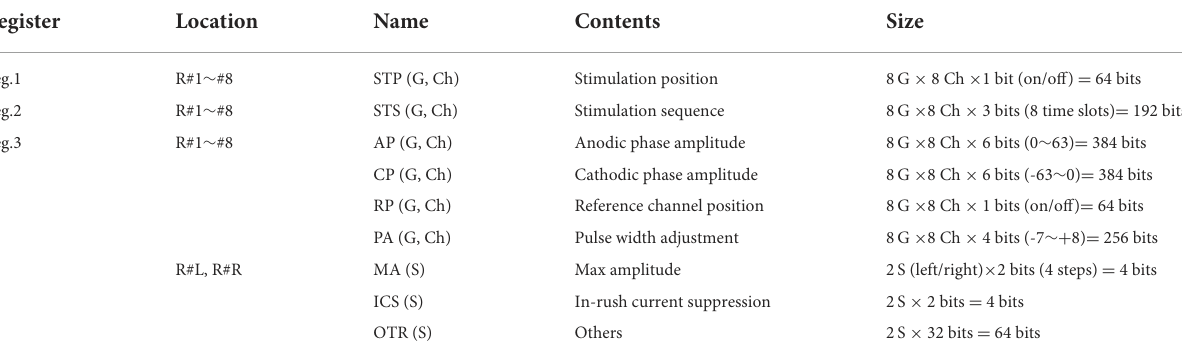
TABLE 1 Setting parameters stored to the built-in